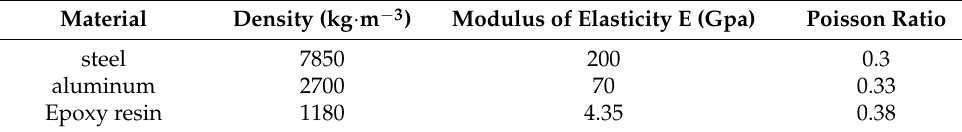
Table 1. The physical parameters of the periodic pipeline material.